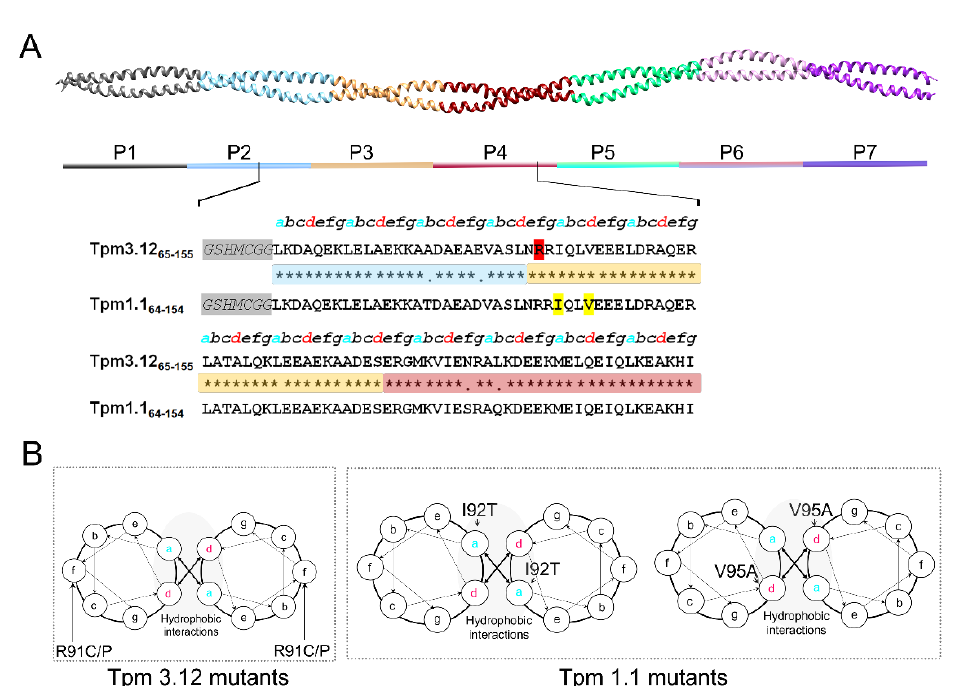
Figure 1. Tpm1.1 and Tpm3.12 peptides design. ( A ) Schematic representation of the fragments with respect to the full-length model of Tpm (PDB ID: 1C1G). Sequence comparison of designed Tpm3.12 and Tpm1.1 fragments. The alignment was performed in UniProt, accession numbers P09493 for Tpm1.1 and P06753 for Tpm3.12. Stars between the sequences indicate identical amino acid residues, dots indicate sites where the sequences differ. Blue, orange, and magenta indicate positions of actin-binding periods 2, 3 and 4, respectively. Lower case italicized letters on top of the sequences show positions of the amino acid residues in heptad repeat and a and d positions are shown in cyan and red, respectively. Mutation sites related to hypo- and hypercontractile phenotypes are highlighted in yellow and red, respectively. The N-terminal fusion peptide (shaded with gray) comprises amino acid residues left after proteolysis of His-tag with thrombin, followed by Cys and elastic Gly-Gly linker introduced during peptide construction. ( B ) Illustration of the coiled-coil wheel where positions of the mutations are indicated by arrowheads.